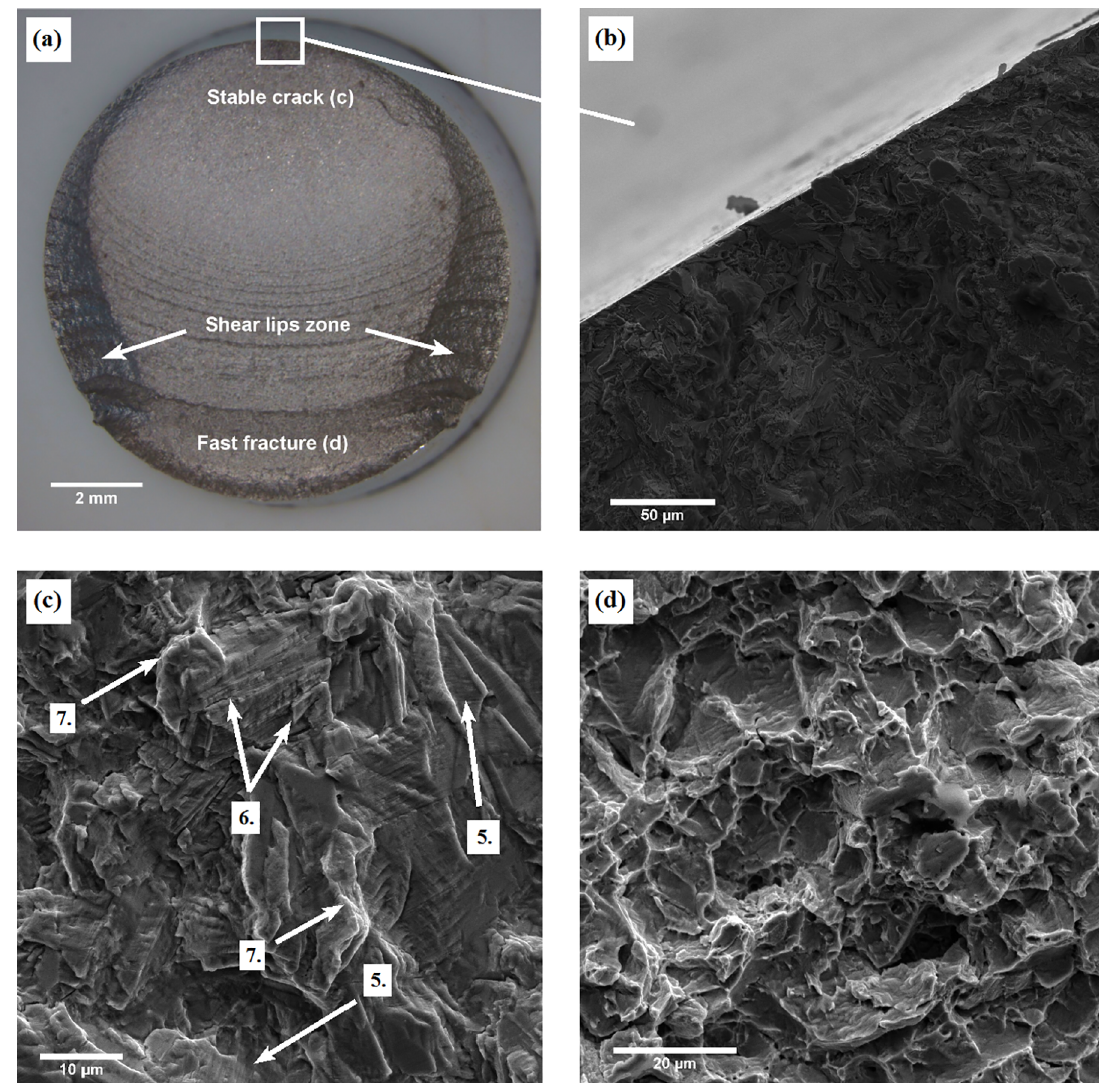
Figure 13. Inconel 625 fracture surface after failure at 3599687 cycles under maximum tension of 306 MPa: (a) appearance of the fracture surface, (b) microscopic crack nucleation region, (c) failure mode in the stable crack growth region, (d) failure mode in the fast fracture